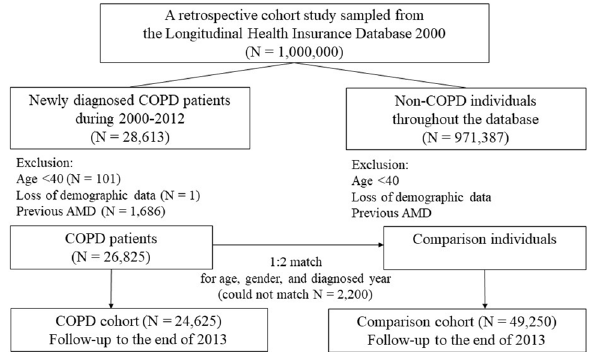
Figure 1. Flowchart of the study